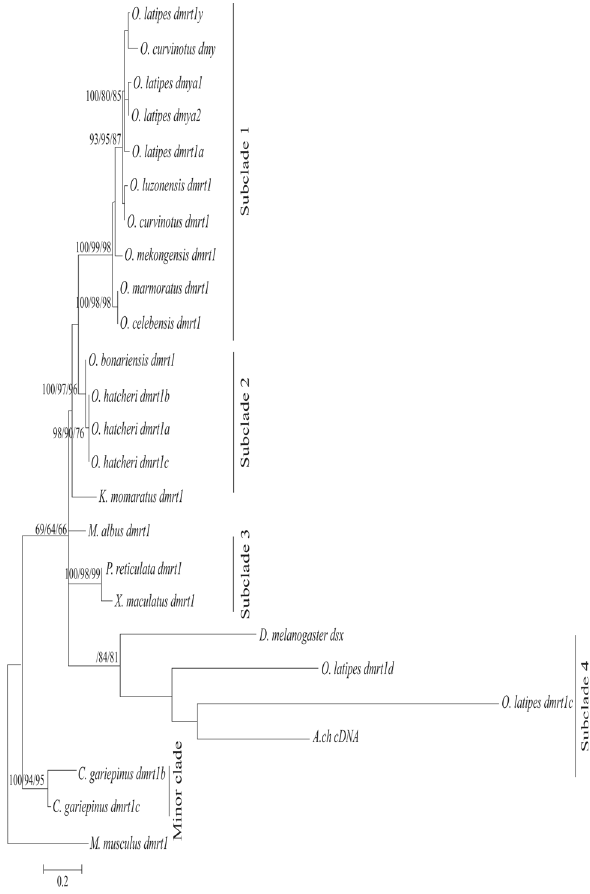
Figure 4 - Maximum Likelihood analyses [under K81+G model with gamma correction)], based on the expressed partial sex-specific cDNA se- quence isolated from Austrolebias charrua ( A.ch cDNA), Dmrt1/Dmrt1bY mRNAlikesequencesand dsx from Drosophila retrieved fromGenBank(Table3).Numbersabovethebranches(lefttoright)corre- spond to the Bayesian posterior probability for clades obtained using BEAST 1.5.4v , followed by ML and MP boostrap support (> 60%) re- spectively, recovered in 1000 replicates.